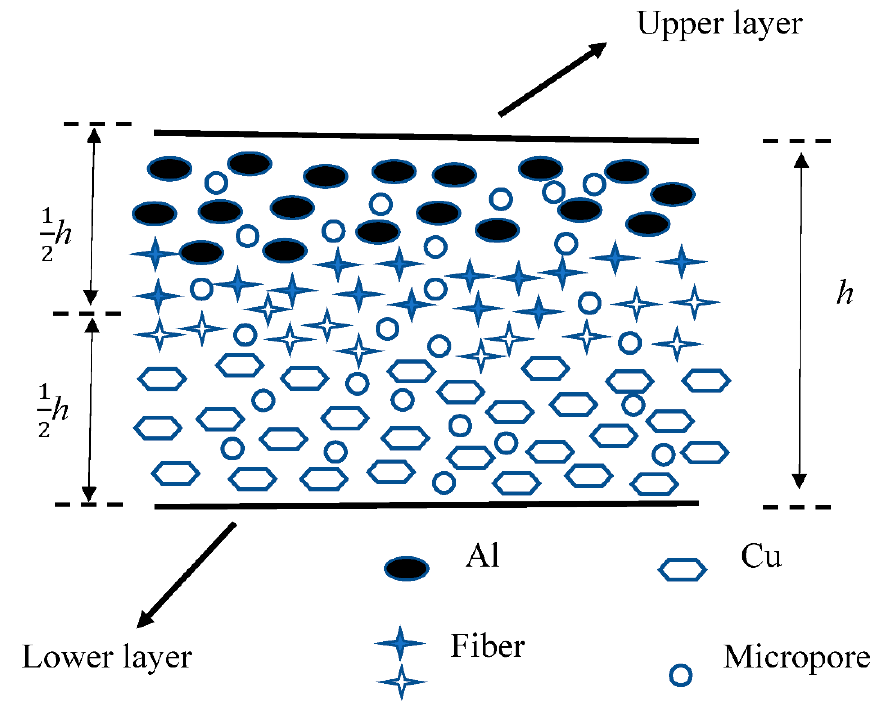
Figure 1. Schematic diagram of a cross-section of Al–Cu functionally graded material distributed along the thickness direction.